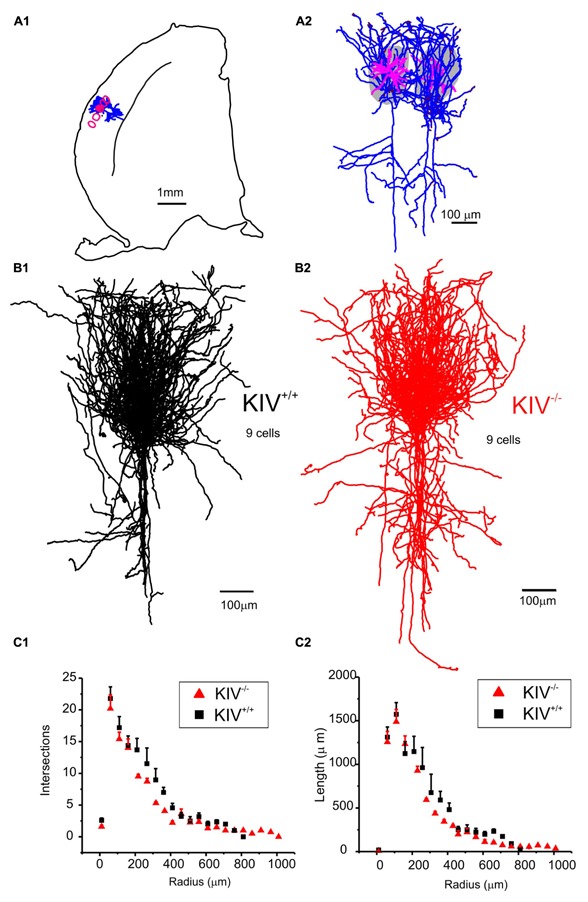
Axonal morphology was unaltered in KIV-/- mice. (A) An example of a pair of reconstructed wild-type spiny stellate cells, located in neighboring barrels (grey areas in A2 and red contour in A1). Note the typical distribution of axonal arbors (blue) within layer IV barrels with projections toward layer II/III, and downward projections toward the white matter. Dendrites (magenta) are largely confined within a single barrel. (B) Reconstructed axonal arbors from 9 pairs of wild-type (B1, black) and littermate mutant neurons (B2, red) were superimposed at the soma location. (C) Sholl analysis was performed to compare the distribution of no. of intersections (C1), and the distribution of total axonal length (C2) along different radius from the soma in 21 wild-type and 10 mutant neurons, respectively. No statistical differences between WT and KIV mice.